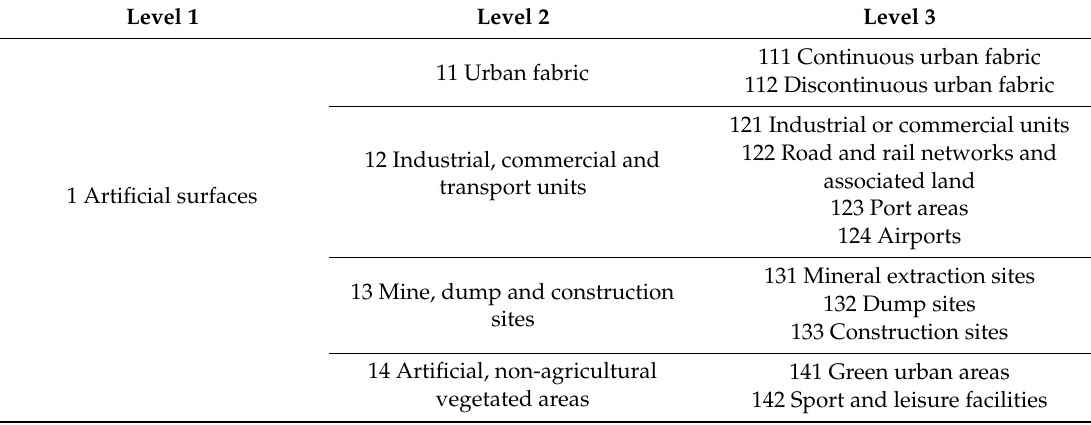
Table 1. CORINE (Coordination of Information on the Environment) land cover (CLC)